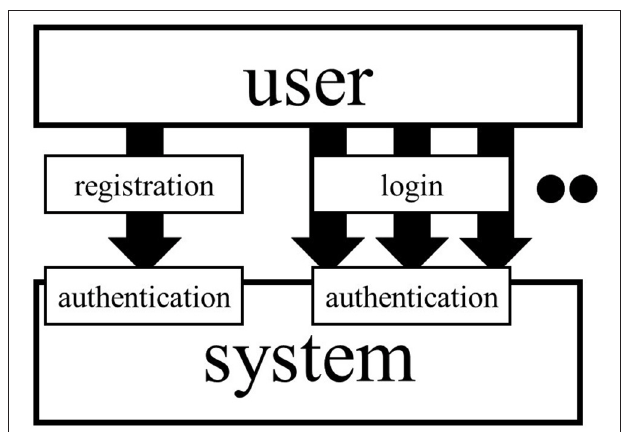
FIGURE 1 | Registration and login. The user needs to be registered before using systems. They have to login when they use systems. Separate considerations are necessary for authentication at the time of registration and